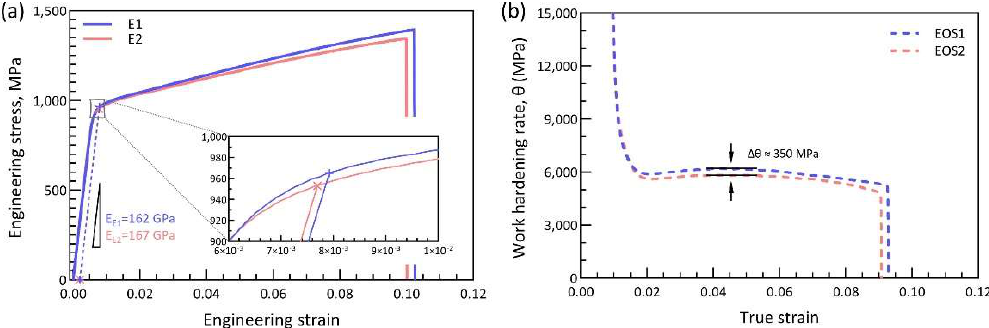
Figure 8. ( a ) Monotonic engineering stress-strain curve; ( b ) plots of work hardening rate as a function of true